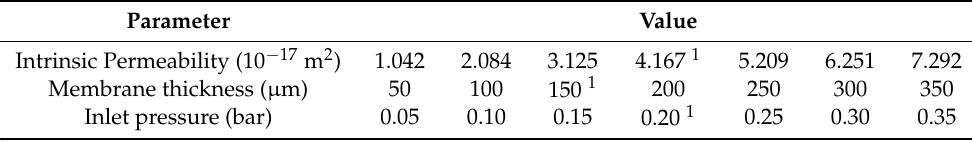
Table 1. Overview of operational parameters values used in a sensitivity